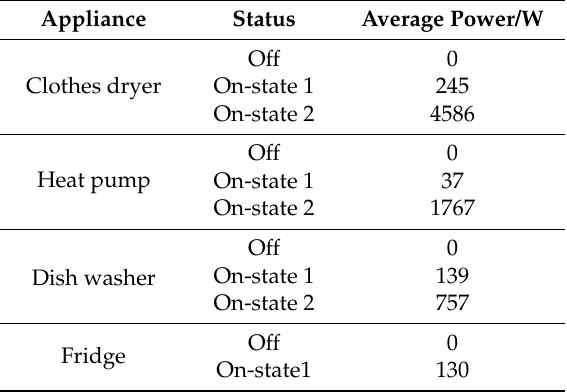
Table 1. Average powers of testing appliances in